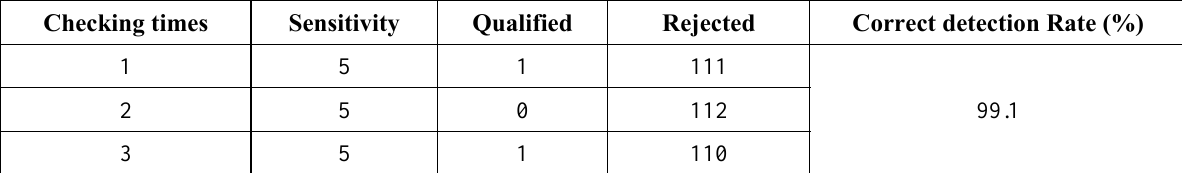
Table 4. Checking results with inspection machine.